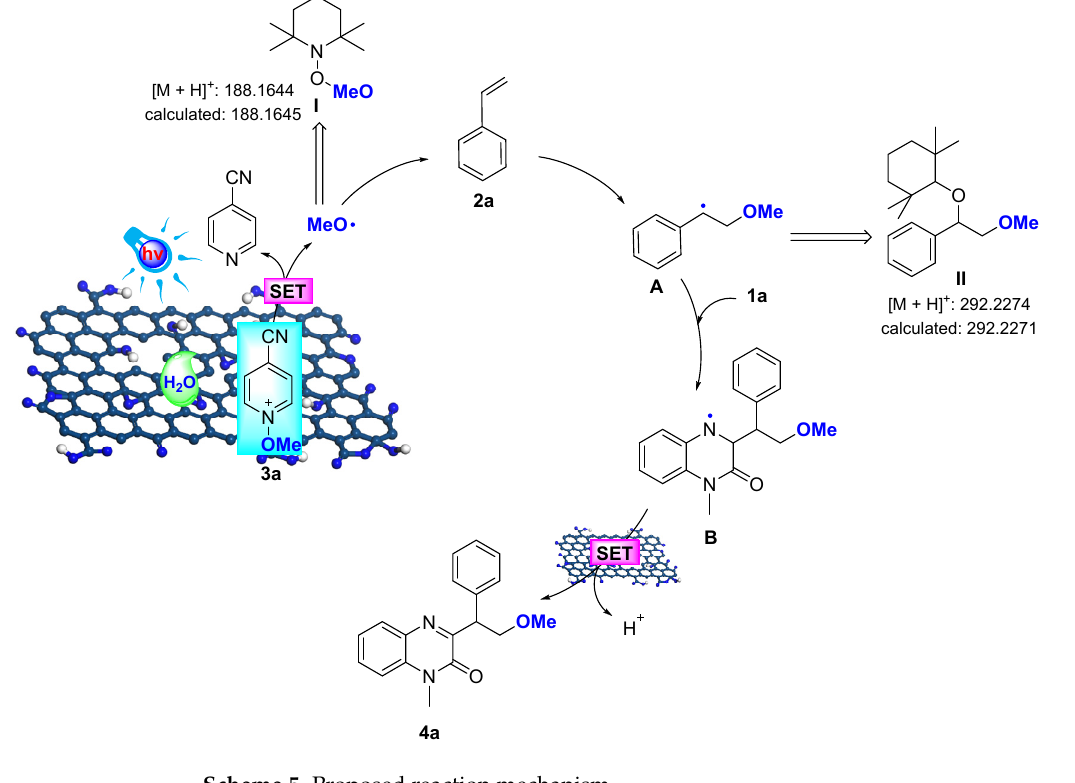
Scheme 5. Proposed reaction